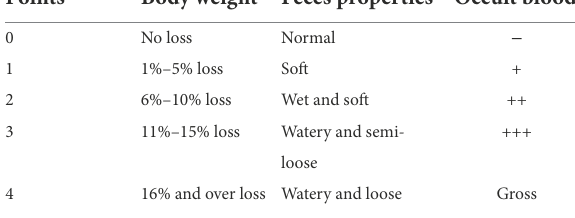
TABLE 1 Disease activity index score